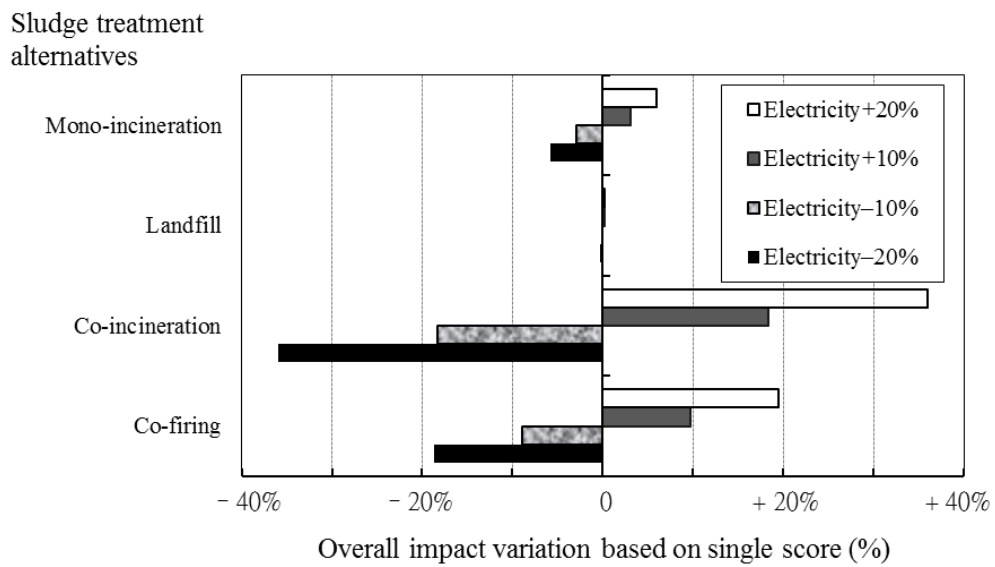
Figure 4. Sensitivity analysis of electricity consumption for four sludge-handling